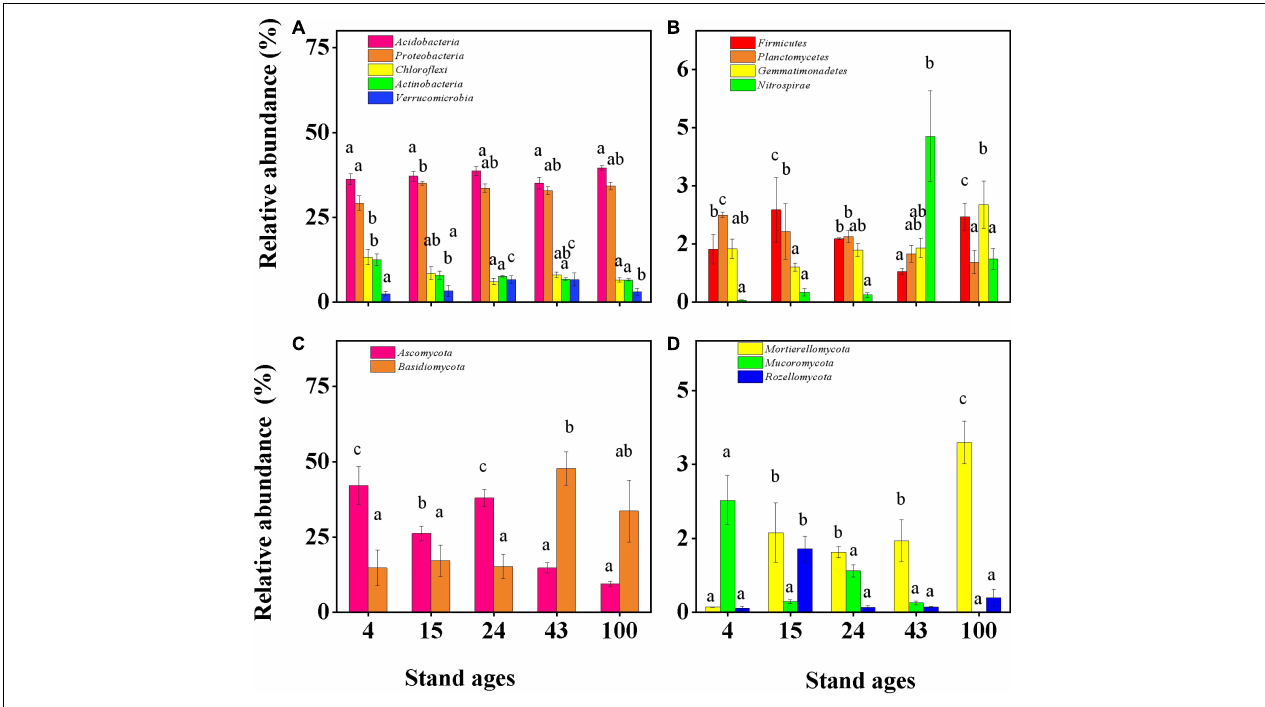
FIGURE 5 | Soil bacteria and fungi with relative abundance above 1% across the Chinese fir planting chronosequence (mean ± SE, n = 3). (A,B) Relative abundances of components of the bacterial community composition at the phylum level. (C,D) Relative abundances of components of the fungal community composition at the phylum level. Bars with different letter(s) are significantly different between stand ages ( p < 0.05) for each individual phylum.